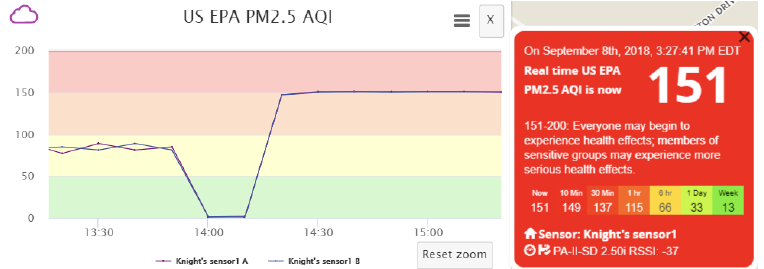
Figure 8. AQI fluctuation for Scenario B with optimized data pollution